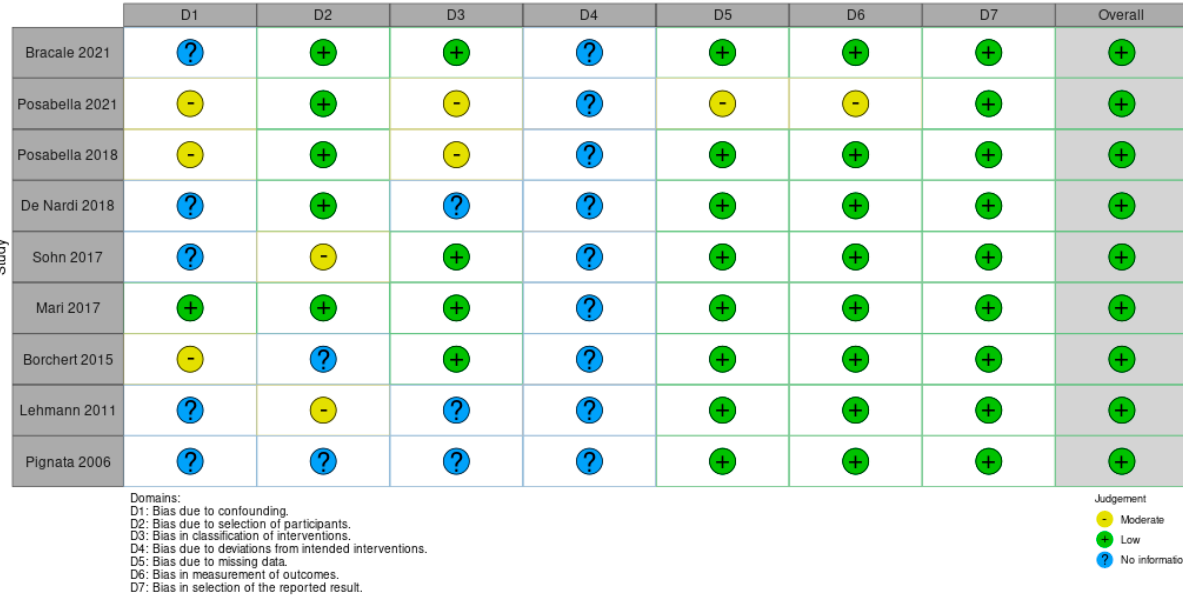
Figure 3. The risk-of-bias judgment of the CCTs, performed according to ROBINS-I tool, risk-of- bias